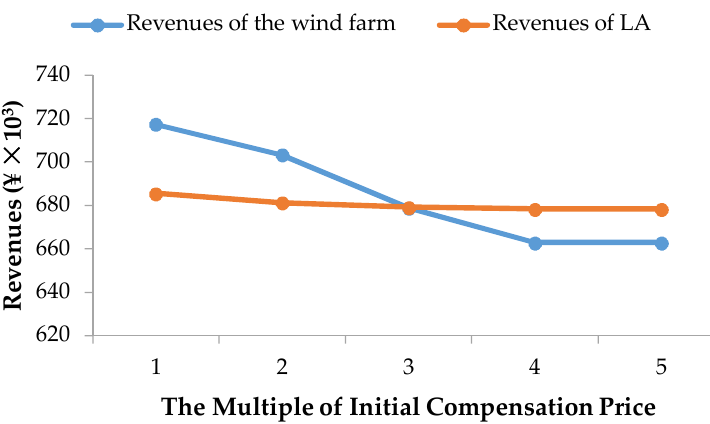
Figure 8. The revenues of both sides under different compensation prices.